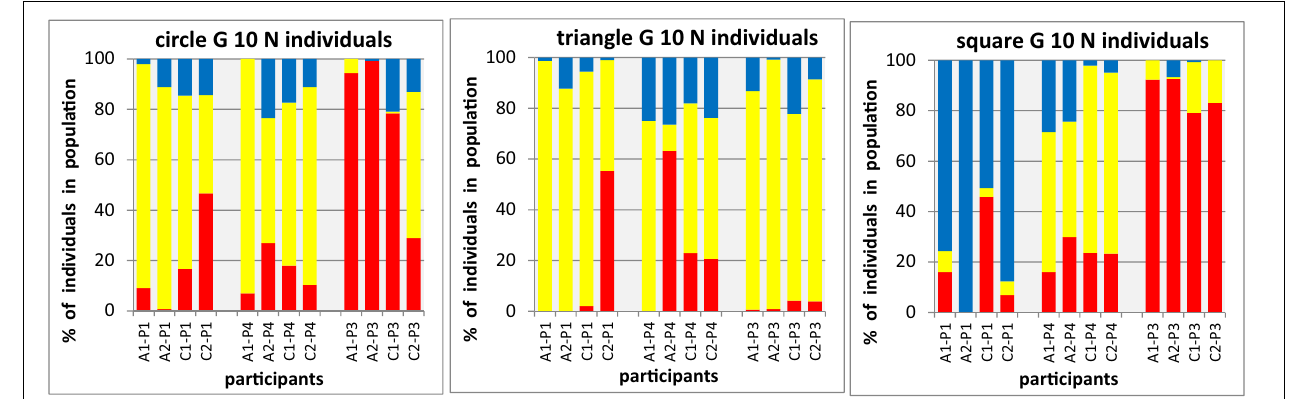
FIGURE 7 | Color proportions in final populations for three participants in four different conditions (as shown as averages in A1, A2 and C1, C2 in Figures 3, 5). Each panel shows for one particular shape (circle, triangle, square) the proportions of red, yellow, and blue population members (shown as stacked bars,